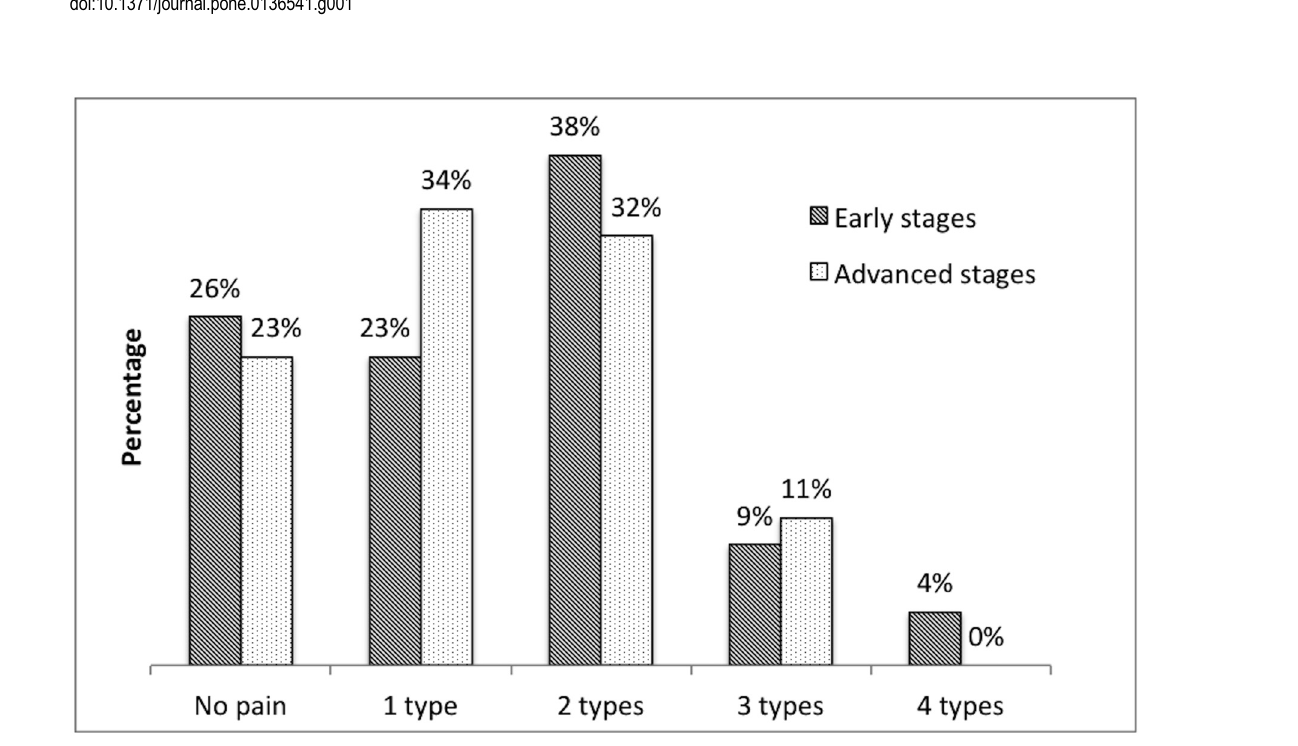
PLOS ONE | DOI:10.1371/journal.pone.0136541 August 26,